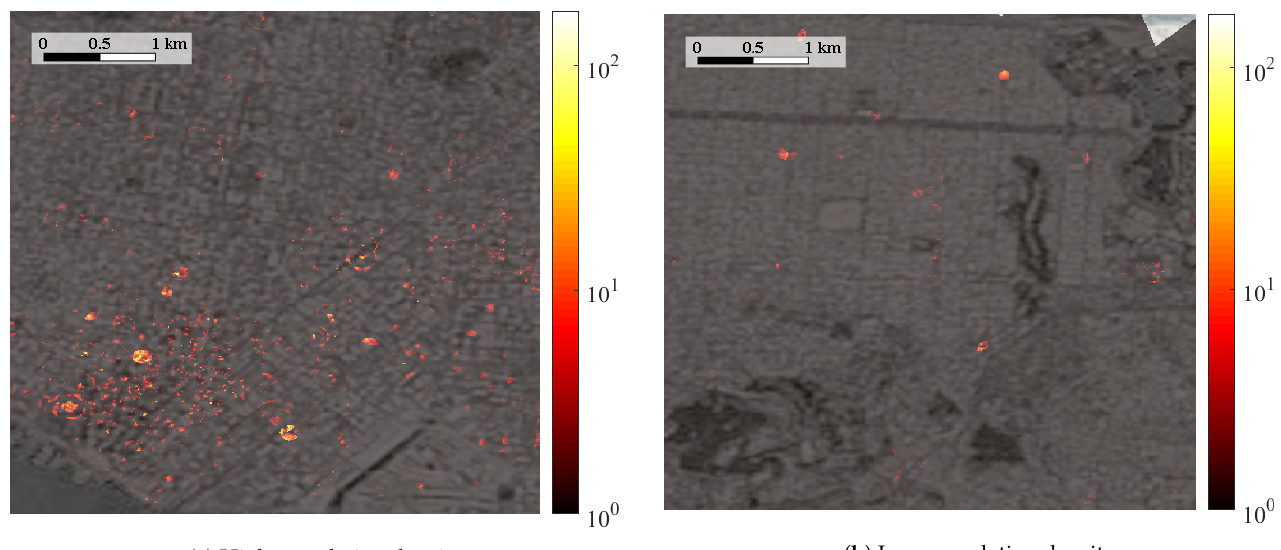
Figure 8. Results of M UE with the Social model in the sections presented in Figure